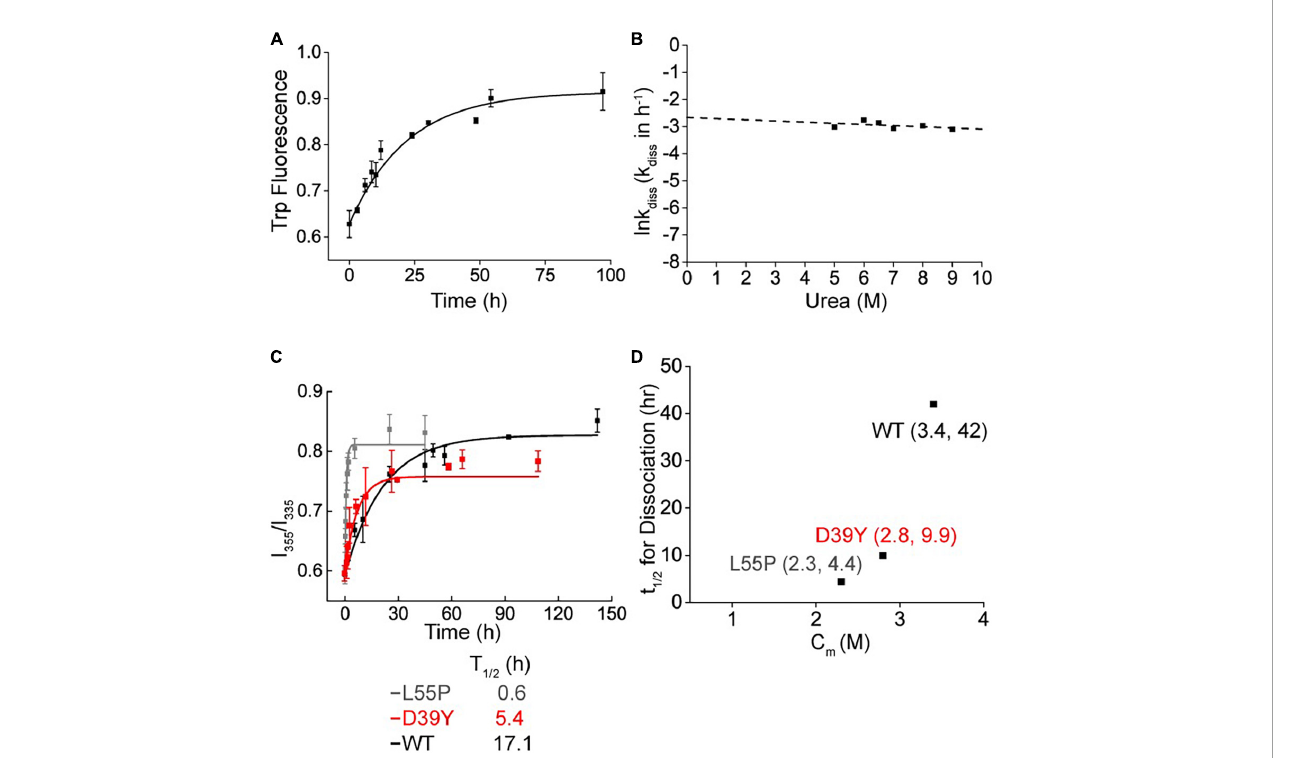
FIGURE3 Kinetic stability of D39Y TTR. (A) Tetramer dissociation measured by tryptophan fluorescence in 9 M urea. (B) The logarithm of the rate of tetramer dissociation, lnkdiss (kdiss in h-1) plotted as a function of urea concentration. The lnkdiss vs. urea concentration plot is linear, allowing extrapolation to 0 M urea. (C) Kinetic stability measured by tryptophan fluorescence in 6 M urea. L55P, gray curve; D39Y, red curve; WT, black curve. (D) Relationship between thermodynamic ( x Axis; Cm of denaturation curve) and kinetic ( y Axis; t1/2 of tetramer dissociation) stability.